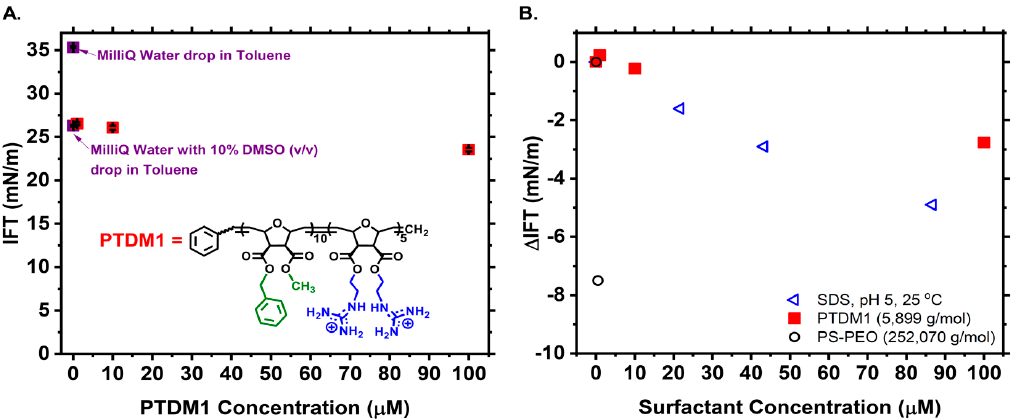
Figure 2. ( A ) Interfacial tension (IFT) measured for an aqueous phase droplet containing Milli-Q ® water, Milli-Q ® Water with 10% DMSO v / v (dark blue squares), or Milli-Q ® Water with 10% DMSO v / v and varying concentrations of PTDM1 (red squares) in a toluene ambient phase. Inset shows the chemical structure of PTDM1. ( B ) Change in interfacial tension ( Δ IFT) between a control solution containing no PTDM1 and solutions containing varying concentrations of PTDM1 (red solid squares).